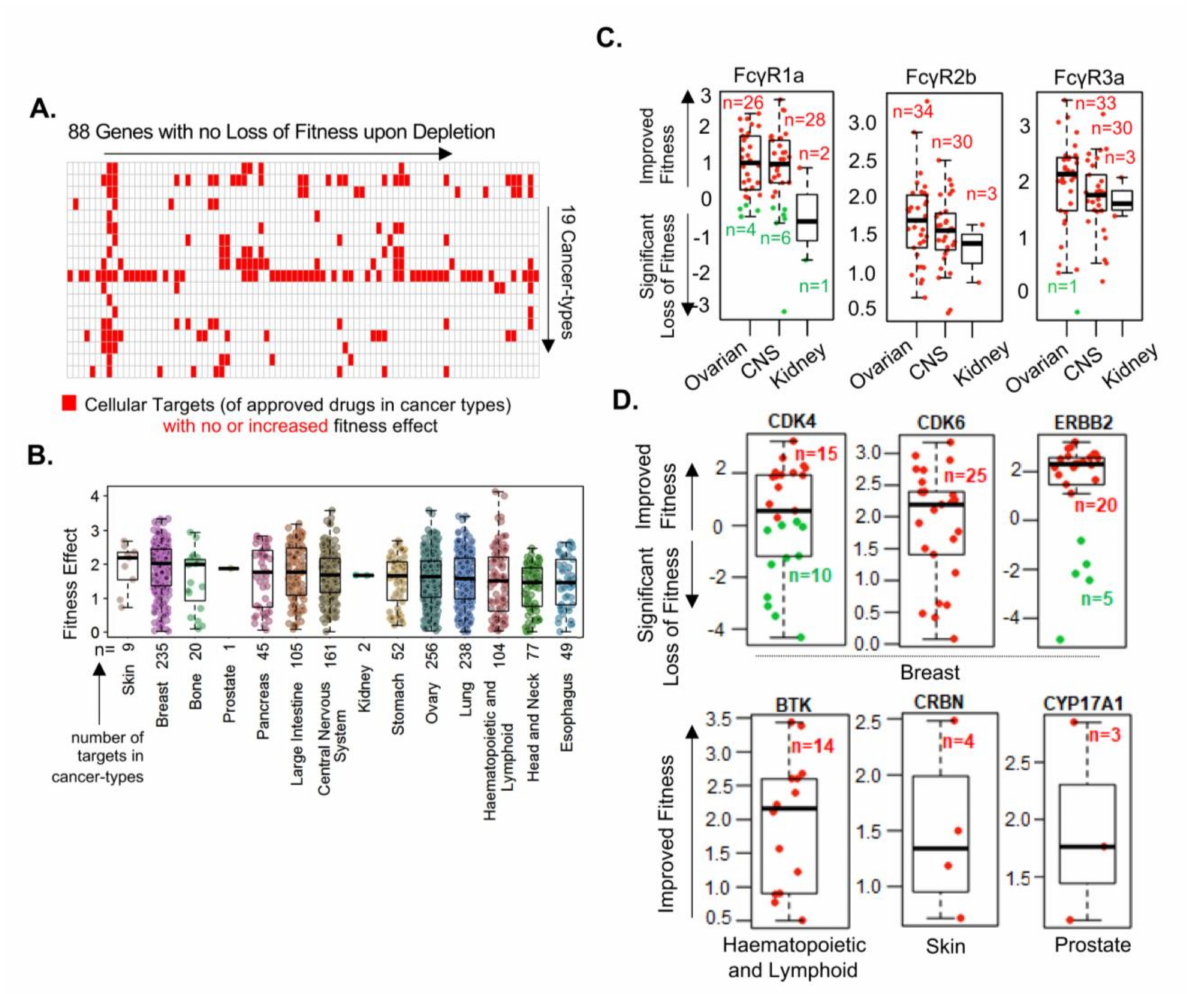
Figure 2. Revelation of cellular molecules with differential effects on cellular fitness. ( A ) Overall distribution of the 88 cancer targets with no loss of cellular fitness upon depletion across the 19 types of cancer cell lines. ( B ) Distribution of the positive fitness effect of depleting the 47 targets across cancer types, for which drugs utilizing these molecules are either approved or not approved. Here, n—collective number of target fitness values among cancer cell lines in a given cancer type; one dot per target per cell line. ( C ) Representative examples of the three fitness genes important in the action of bevacizumab in the three referred cancer types. ( D ) Selected examples of the above representative targets in cancer-types for which drugs targeting these molecules are approved using data from Drug bank and corresponding Fitness score for were derived from the Cancer Dependency